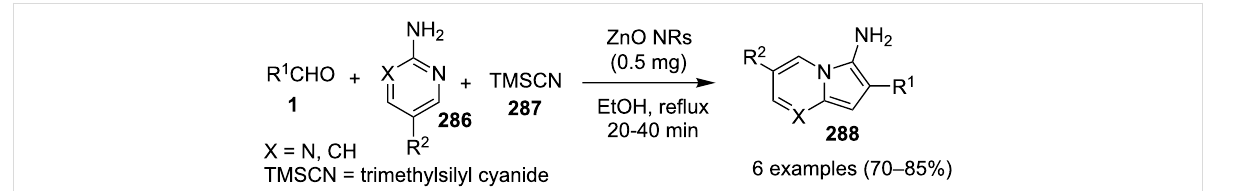
Scheme 93: Mechanism for the synthesis of chromeno-annulated IPs.